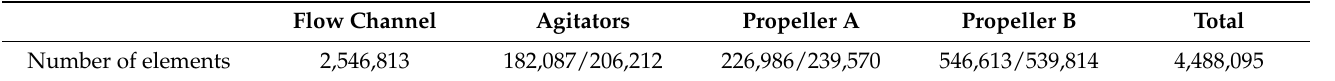
Table 2. The number of grids per